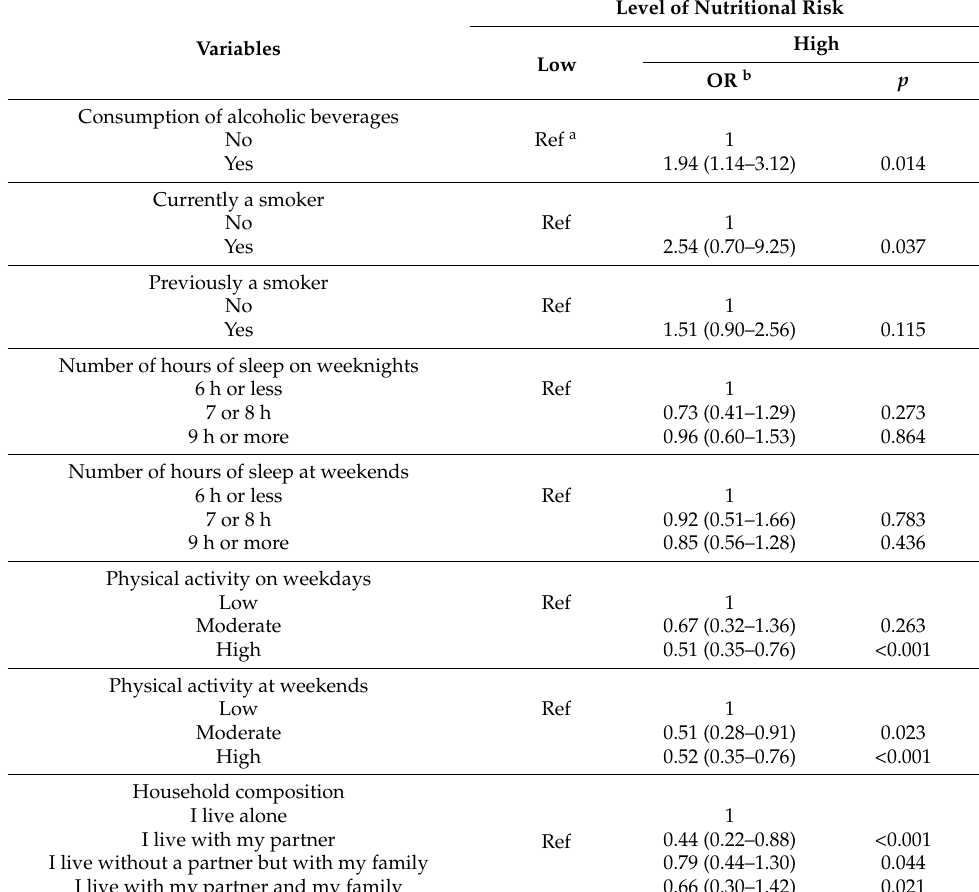
Table 5. Odds ratio for high versus low nutritional risk with selected lifestyle characteristics.